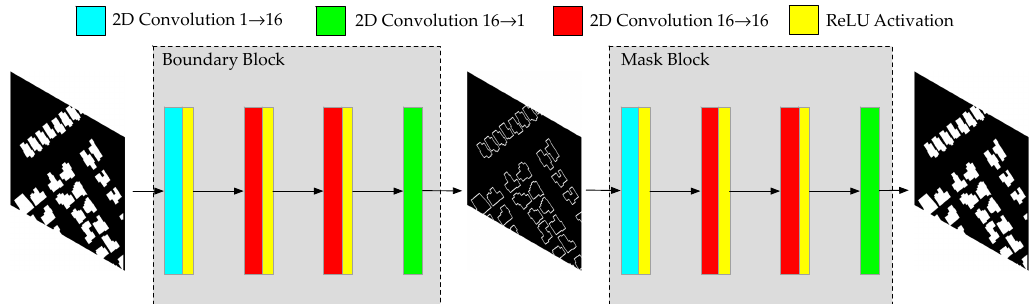
Figure 2. Overview of the CycleNet architecture. The yellow rectangle represents the ReLU activation layer. The other three colors of rectangles dedicate 3 different convolutional layers, and the padding and stride are consistently set to 1. The kernel size of the convolution layer with the color of light blue, red and green are 1 × 16 × 3 × 3, 16 × 16 × 3 × 3 and 16 × 1 × 3 × 3, respectively. The boundary map is predicted from a building mask map through a boundary block, while the mask block map recovers the boundary map back into the building mask map.